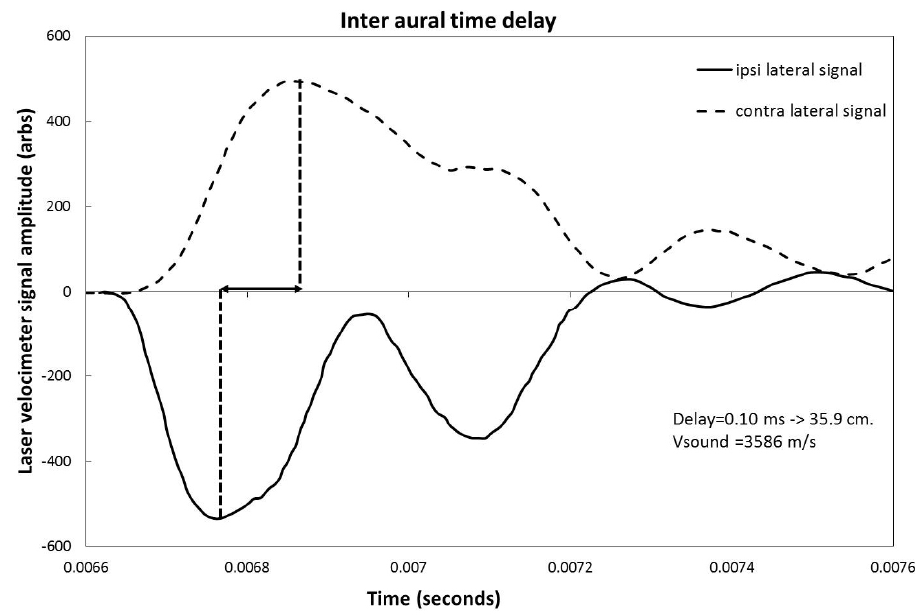
Figure 5. Measurement by laser velocimeter of the inter-aural time response of the round window driven by a 220 µs square pulse. For better visualization, the ipsilateral signal (full line) has been inverted with respect to the contralateral signal (dashed line).